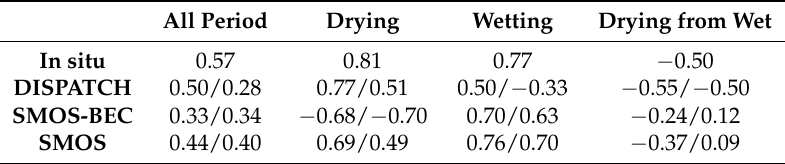
Table 2. Correlation between soil moisture (SM) and latent heat flux normalised by net radiation (Le/Rnet) for the different analysed periods using the in situ data (considered the reference) and SM from the different satellite-based soil moisture (SBSM) products, where the results are provided after applying a low-pass filter of 15 days (as in Figure 8, first values of the table) and without any smoothing of the SM signal (second value in the table). Note the better agreement with the in situ values when applying the